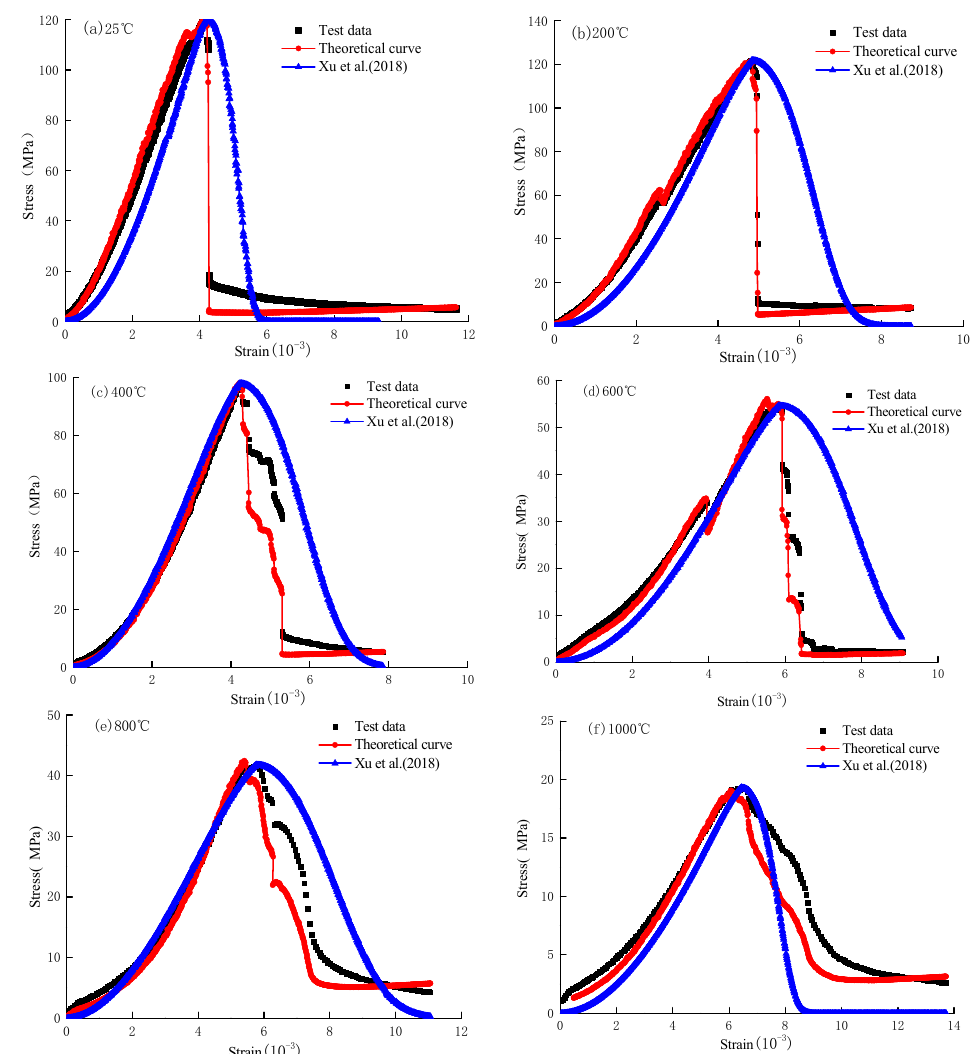
Figure 5. Comparison between experimental and theoretical curves at various temperatures. The accumulation and dissipation of energy are accompanied by the whole process of rock deformation and failure. Energy dissipation can reflect the whole process of rock from micro defect to deterioration during loading. It can be seen from Figure 6 that the model can not only simulate the rock stress–strain relationship in various stages before reaching peak stress, but can also better reflect the phenomena of stress rapid decline after peak strength, which is closer to the actual situation, indicating that the thermal damage constitutive model of rock based on energy dissipation is in good agreement with the ex- perimental curve, which verified the rationality of model. The established model reflects